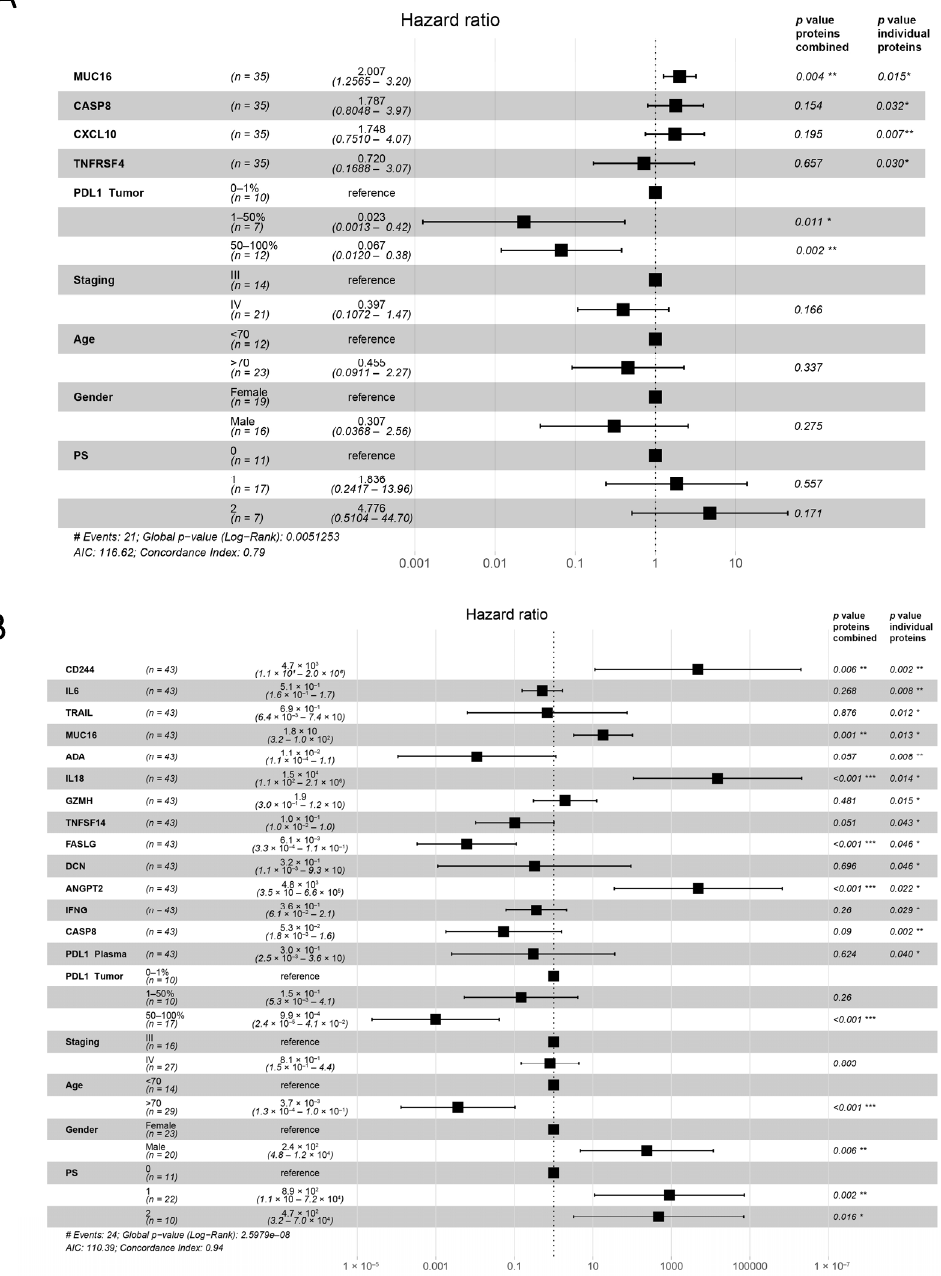
Figure 5. Hazard ratio forest plots. Data are based on multivariate Cox regression analysis for ( A ) progression-free survival (PFS) and ( B ) overall survival (OS). p -values are displayed for the multivariate analysis when each protein was analyzed individually and when all the proteins were combined. (* p ≤ 0.05, ** p ≤ 0.01, *** p ≤ 0.001, PS–performance status).